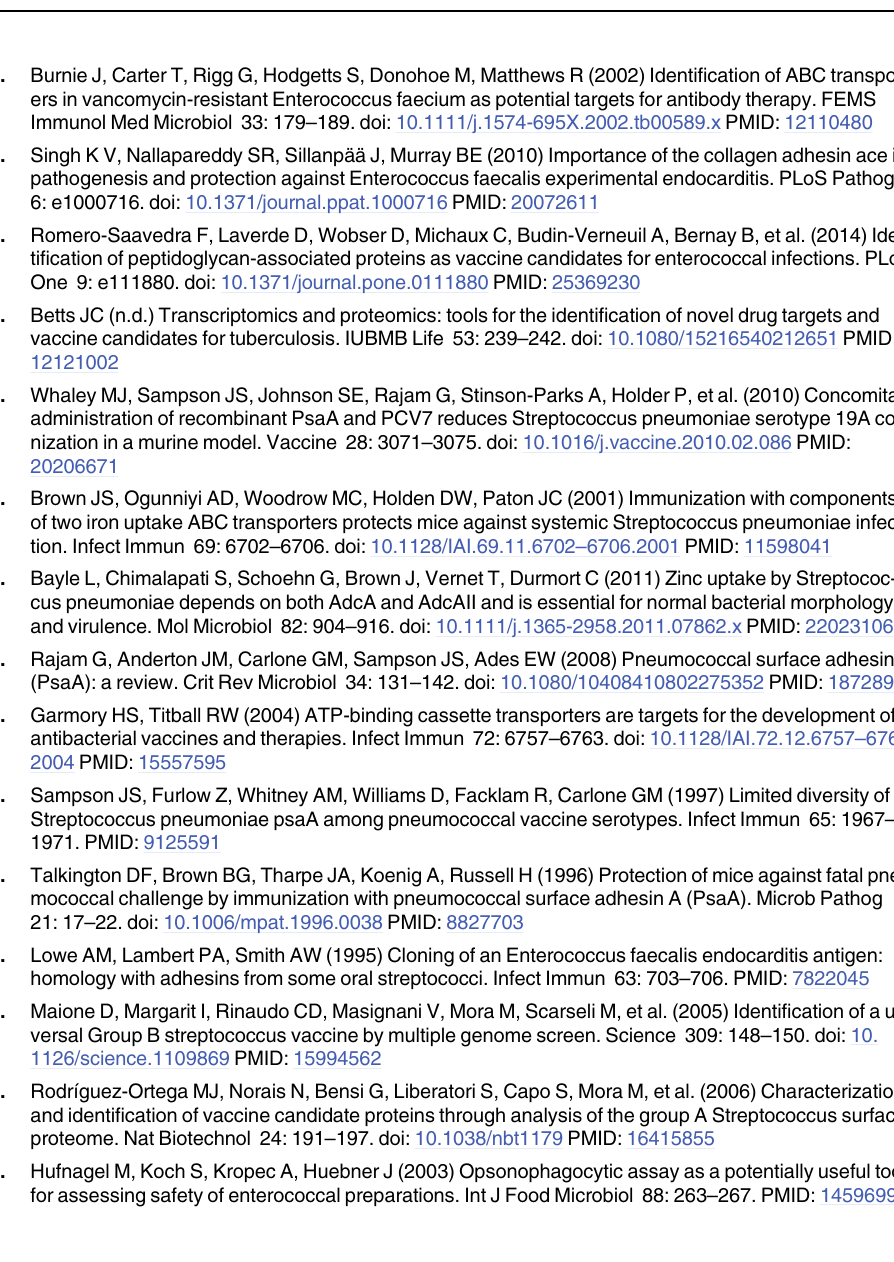
PLOS ONE | DOI:10.1371/journal.pone.0136625 August 31,